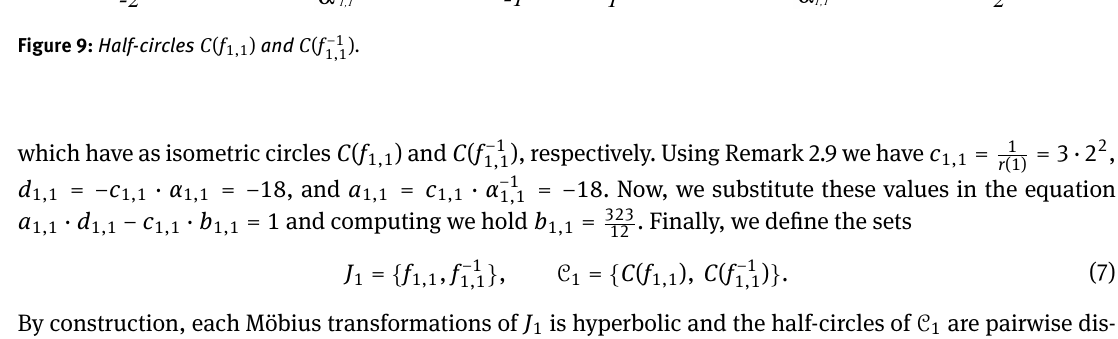
which have as isometric circles C ( f 1,1 ) and C ( f −1